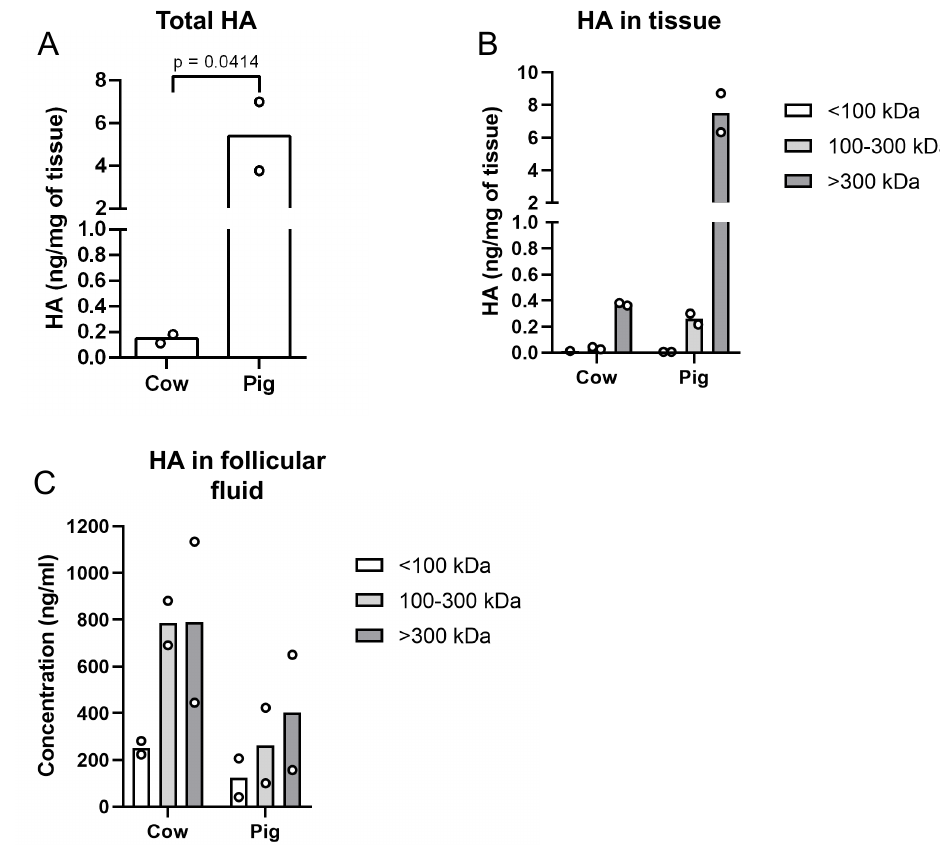
Figure 7. Bovine and porcine total and molecular weight fractionated HA in ovarian tissue and follicular fluid. ( A ) Total HA content in bovine and porcine ovarian tissue was measured using an ELISA–like assay. Column fractionation was used to separate bovine and porcine ovarian tis- sue and follicular fluid HA into three molecular weight fractions, <100 kDa, 100–300 kDa, and 300 kDa, and then HA concentration in each fraction was measured using an HA ELISA-like assay for ( B ) tissue and ( C ) follicular fluid. Circles represent values from individual animals. The p -value is as